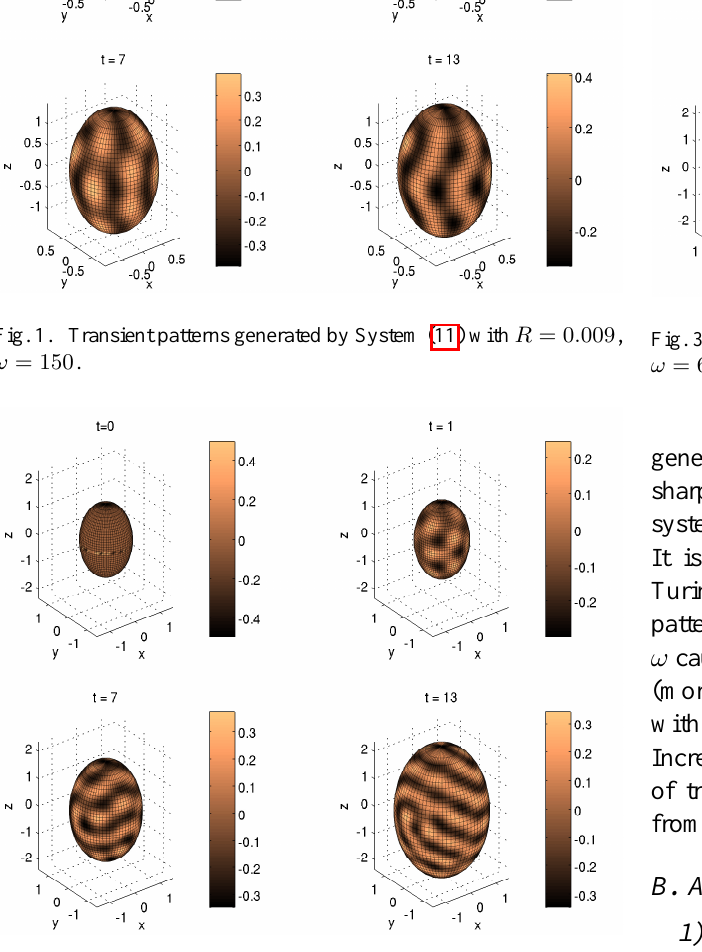
Fig. 2. Transient patterns generated by System (11) with R = 0 . 045 , ω = 150 .